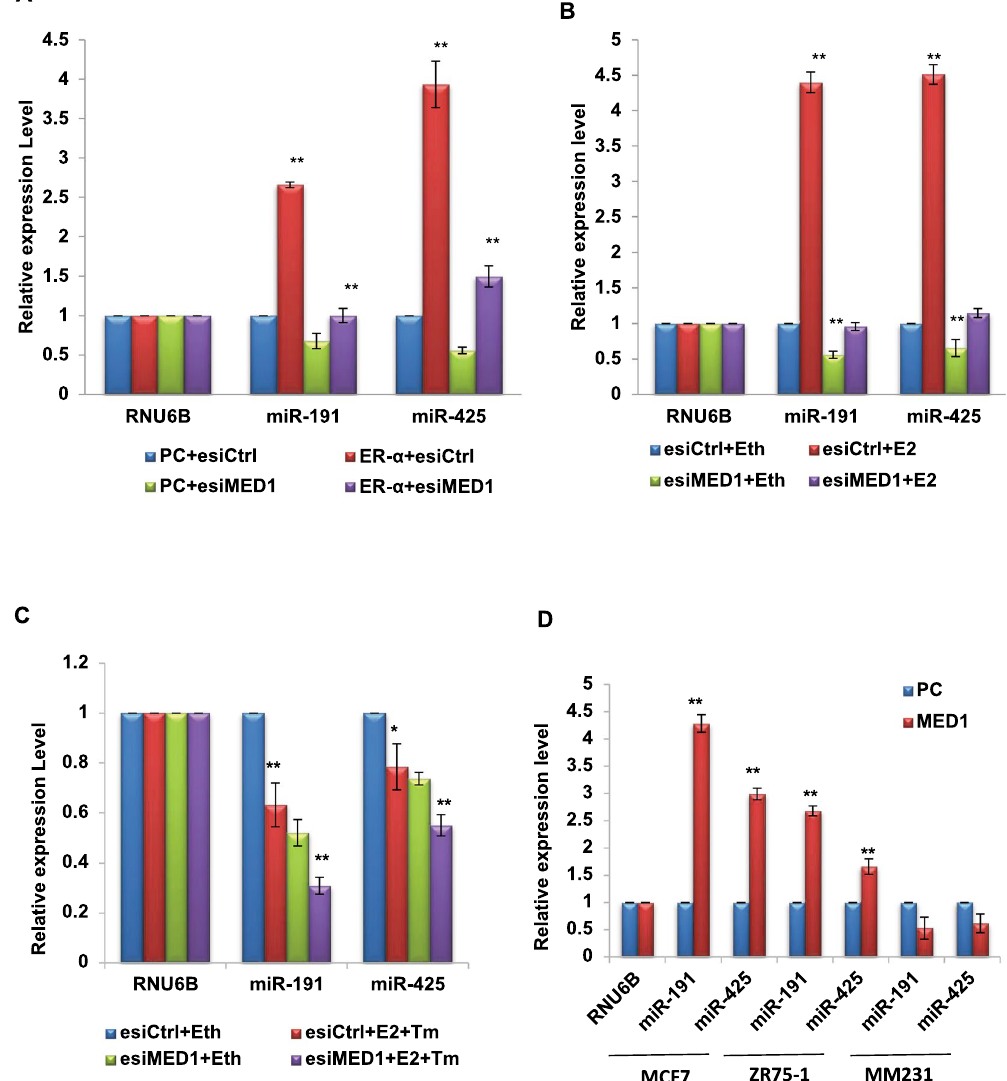
Figure 3. Effect of ER- α and MED1 on transcriptional regulation of miR-191/425 cluster. ( A–C ) MED1 or ER- α were overexpressed or inhibited and stem loop qRT-PCR was done to check the levels of miR-191 and miR-425 ( A ). Estrogen (E2) or vehicle (ethanol, Eth) treatment was given along with esiMED1 or tamoxifen (Tm) and the effect on miR-191/425 was observed using stem loop qRT-PCR. ( B , C ) The data was normalized to U6 small RNA (RNU6B) using 2 −Δ Ct method. ( D ) Levels of MED1 were transiently modulated using pCDNA3.1-MED1 (MED1) or pCDNA3.1 (PC) in a panel of ER + ve/-ve breast cancer cell lines (MCF7, ZR75-1, MDA-MB-231) and effect on miR-191/425 levels was tested using stem-loop qRT PCR. Induced levels of both the cluster miRNAs (miR-191 and miR-425) were observed in response to MED1 overexpression in ER + ve cell lines (MCF7, ZR75-1) while opposite results were observed for ER-ve cell line (MDA-MB-231). Thereby confirming that MED1 mediated induction of miR-191/425 occurs in an ER-dependent manner. The graphical data points represent mean + S.D of at least three independent experiments ( ** P < 0.05). Error bars denote +